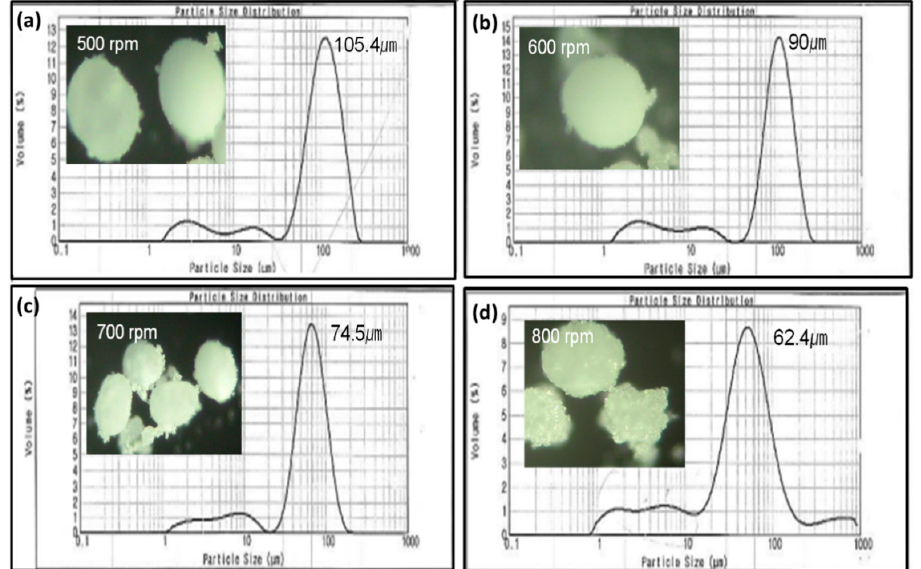
Figure 4. Video-microscopic images and particle size distributions of CLP agglomerates obtained when IPA/Hex [40:60, v/v] was used as anti-solvent at a stirring speed of ( a ) 500 rpm, ( b ) 600 rpm, ( c ) 700 rpm, and ( d ) 800 rpm. rpm, and ( d ) 800